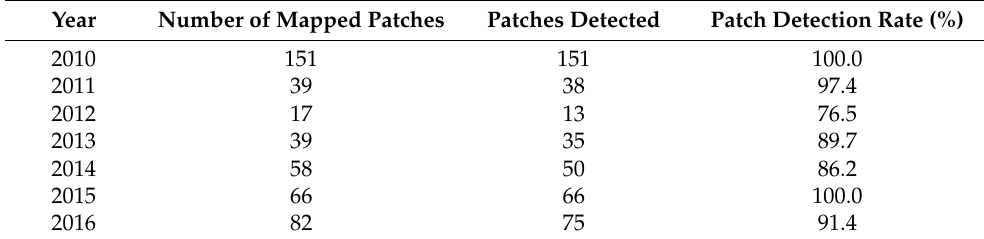
Table 9 outlines patch detection rates for datasets from 2010 to 2016. Detection rates ranged from 76.5% to 100%. Table 9. Summary of alligator weed patch detection rates between 2010 and 2016. Year Number of Mapped Patches Patches Detected Patch Detection Rate